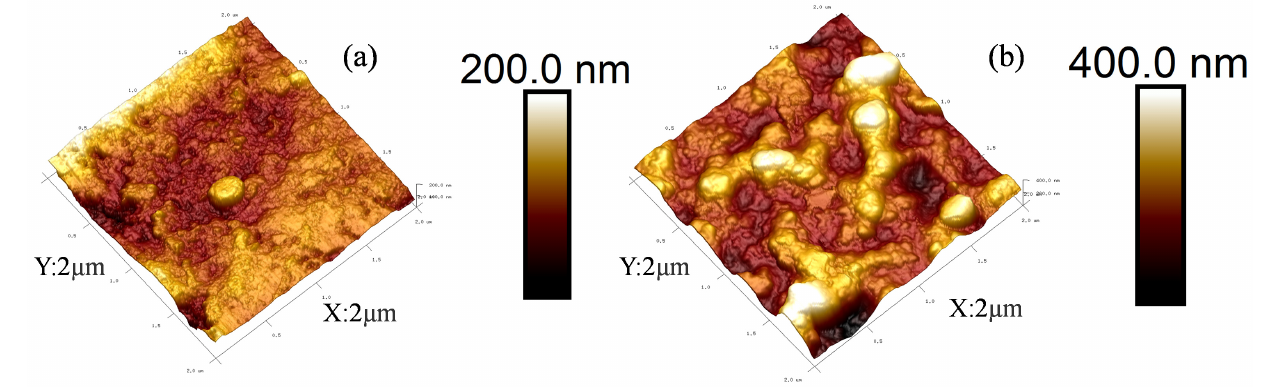
Table 2. Surface properties of membranes. Membrane Figure 4. AFM photos of PMIA substrate ( a ) and PMIA HF TFC NF membrane ( b ).